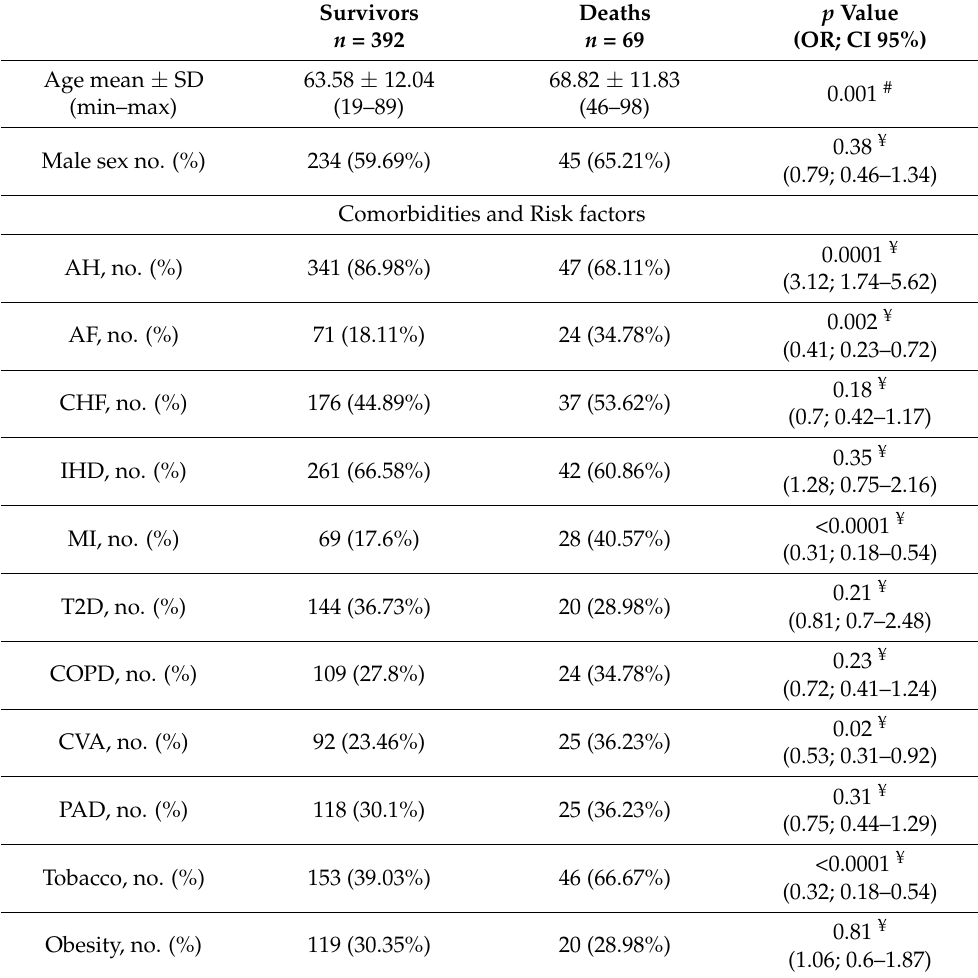
Table 2. Demographic, comorbidities, risk factors, type of dialysis access of the two sub-groups evaluated according to the poor